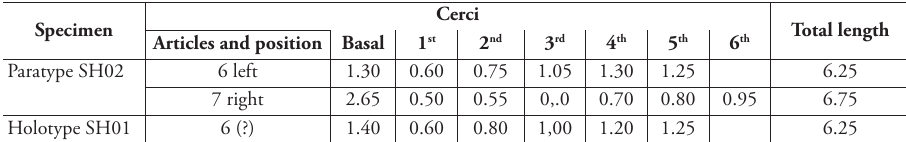
Table 4. Pacificampa nipponica Sendra, sp. n., cercal articles length and total length (units in mm) includ- ing number of articles of each